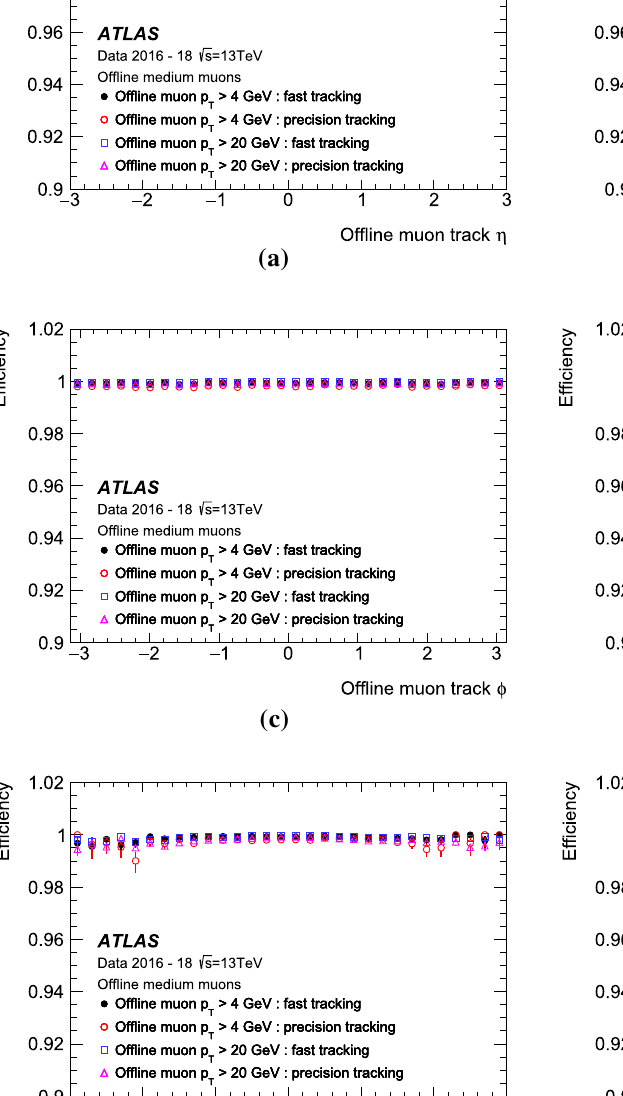
the offline reconstructed muon z 0 , e the offline reconstructed muon d 0 , and f the mean number of pile-up interactions, (cid:4) μ (cid:5) . Efficiencies are shown for both the fast tracking and precision tracking algorithms. Sta- tistical Bayesian uncertainties are shown, using a 68.3% confidence interval and uniform beta function